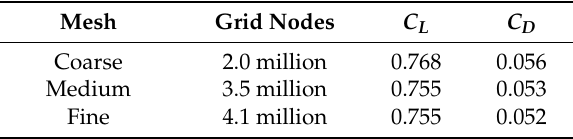
Table 4. Results of the mesh independence